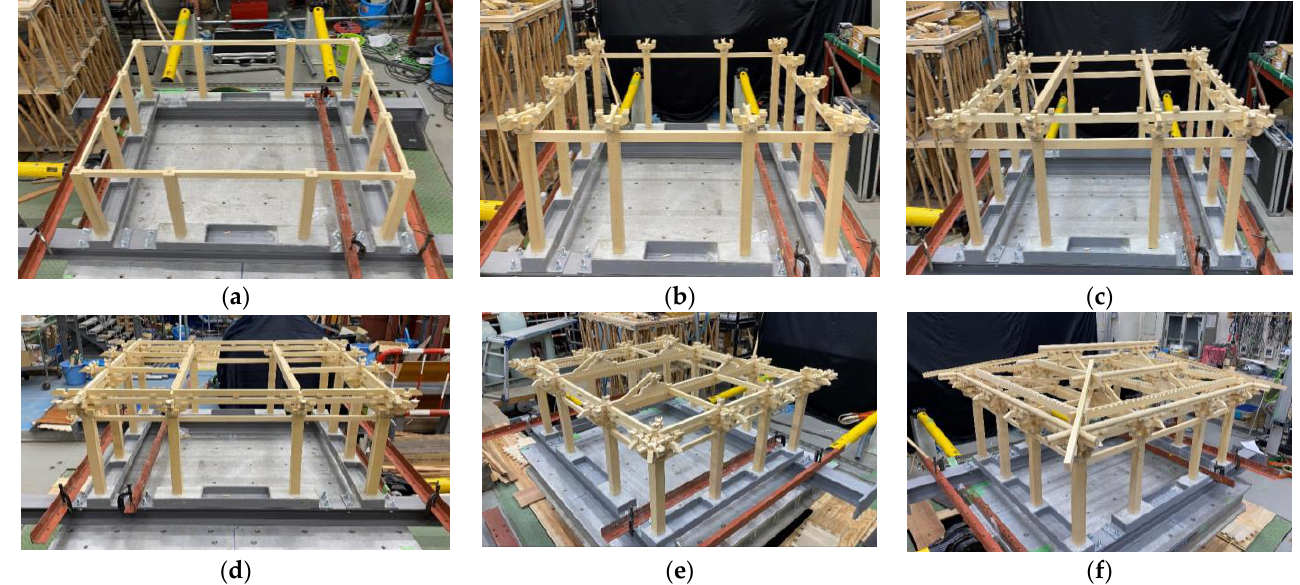
Figure 4. Assembly process of the Nanchan Temple model (produced by the authors). ( a ) Placement of columns and Lan’E . ( b ) Placement of column head Dou Gong. ( c ) Placement of Da Liang and Zhutou Fang. ( d ) Placement of second floor Zhutou Fang and other components. ( e ) Placement of Jiao Bei, Cha Shou, and Tuo Feng. ( f ) Placement of upper beam frame.